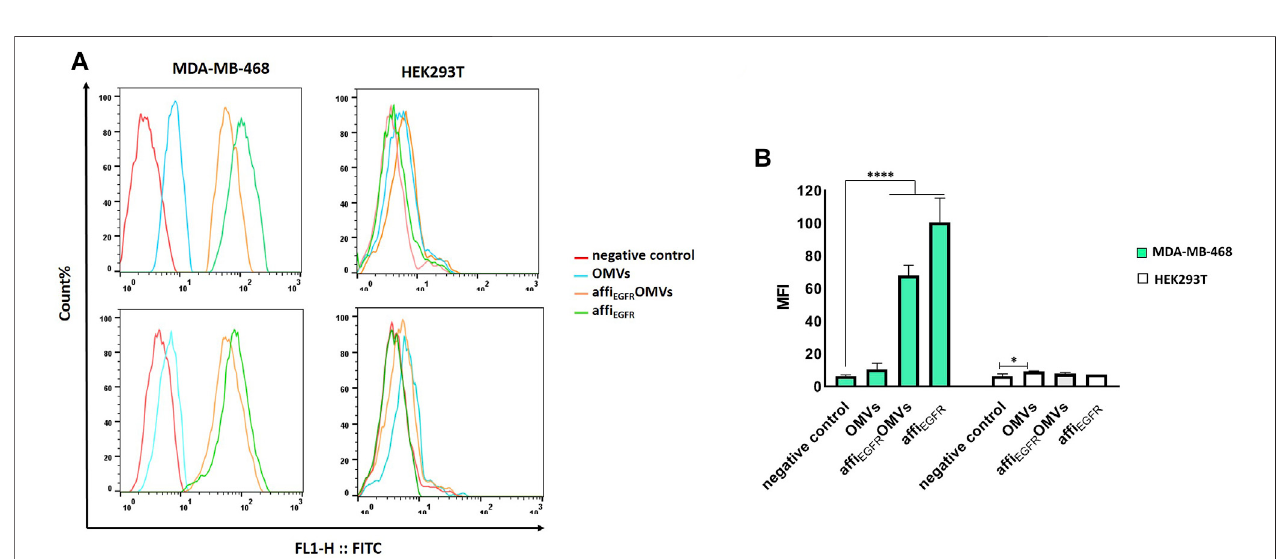
FIGURE 3 | Binding capacity of the OMVs, af fi EGFR -OMVs, and af fi EGFR to EGFR protein was assessed using ELISA. (A) Af fi EGFR -OMVs and the puri fi ed af fi EGFR attach to EGFR protein, while no EGFR binding is observed for non-targeted OMVs even at the highest concentration. (B) Af fi EGFR -OMVs and the puri fi ed af fi EGFR speci fi callybindtotheMDA-MB-468cellsexpressingEGFR.CetuximabwasappliedasapositivecontrolforEGFR-speci fi cbinding.OMVsandthepuri fi edproteinwere explored by consecutive incubation with anti-af fi body antibody and HRP- conjugated rabbit anti-goat IgG. Data are expressed as the mean ± SEM from three independent experiments (*** p < 0.001).